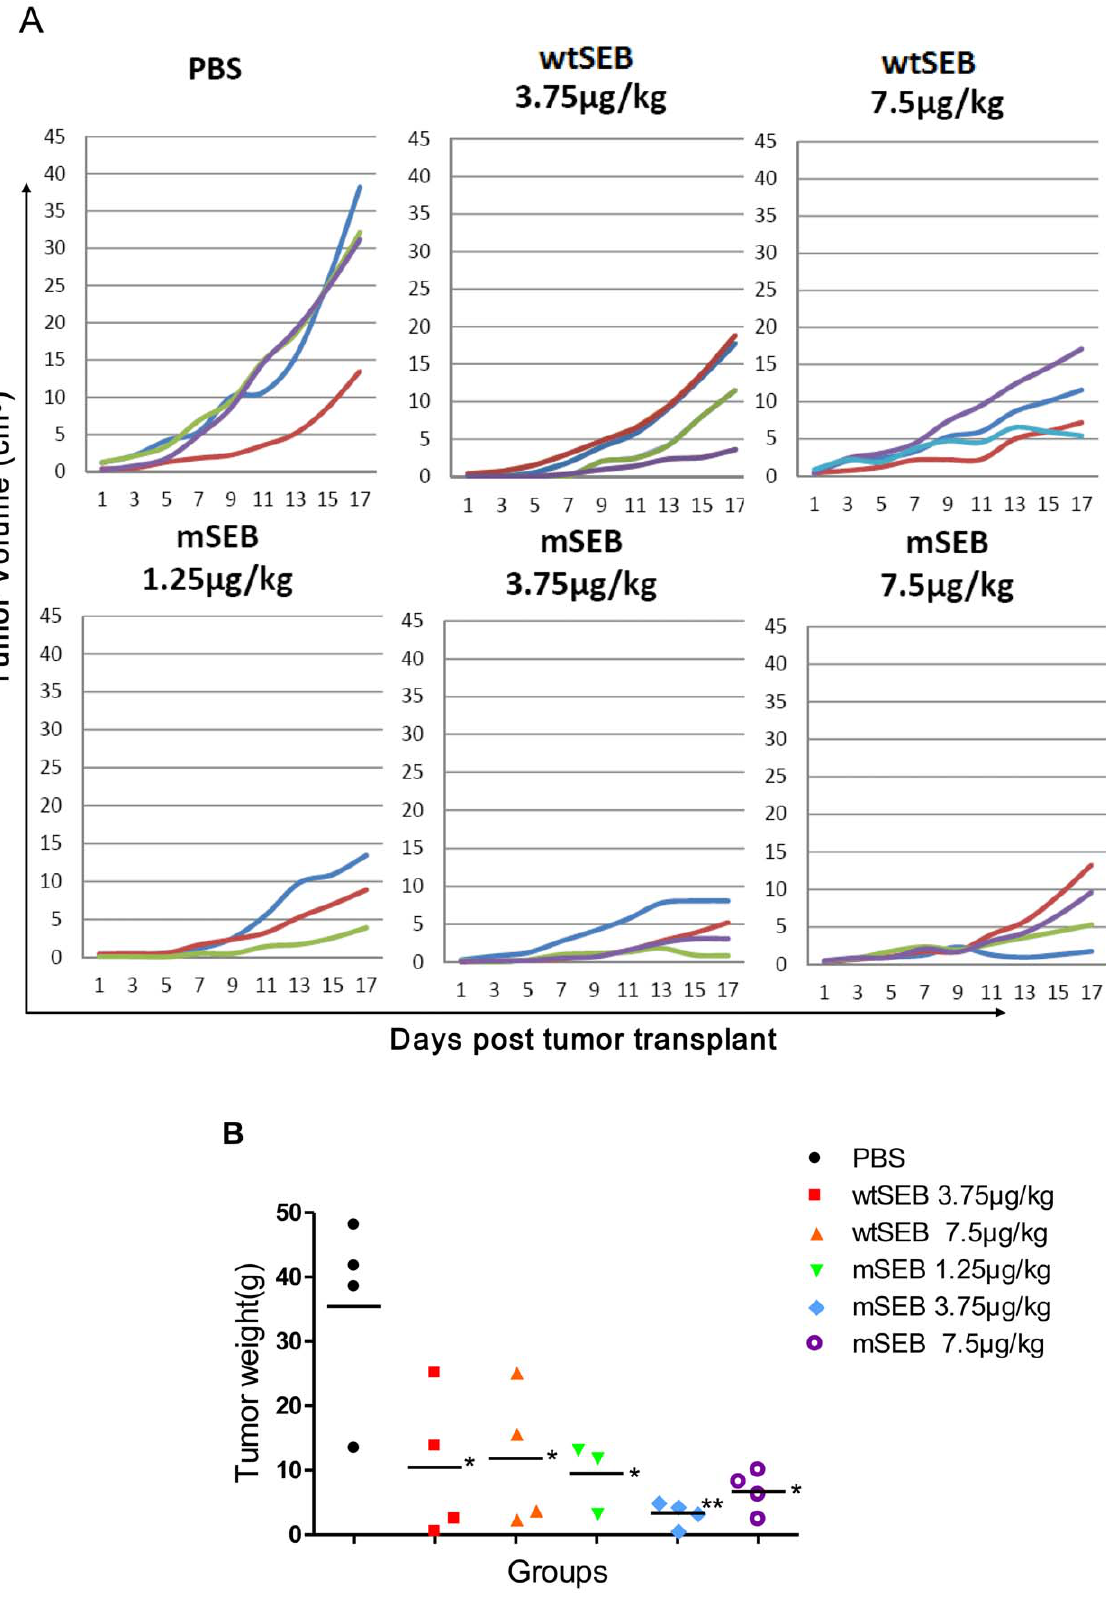
Figure 6. Administration of mSEB to rabbits inhibited growth of VX2 tumors. (A) Comparison of tumor growth curves of rabbits by group. Each line represents tumor growth in a single rabbit. (B) Comparison of tumor weights by group. Each symbol represents the tumor weight from a single rabbit. Horizontal lines indicate the mean tumor weight in each group. Comparison versus PBS controls: * P , 0.05, ** P , 0.01. doi:10.1371/journal.pone.0055892.g006 PLOS ONE |